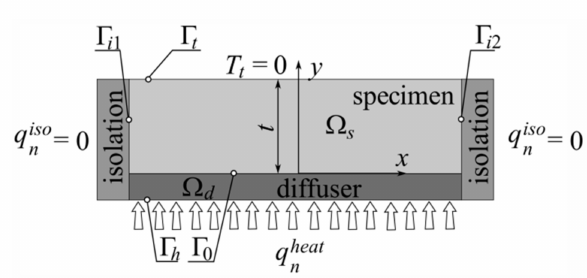
Figure 1. Schema of the virtual stand.